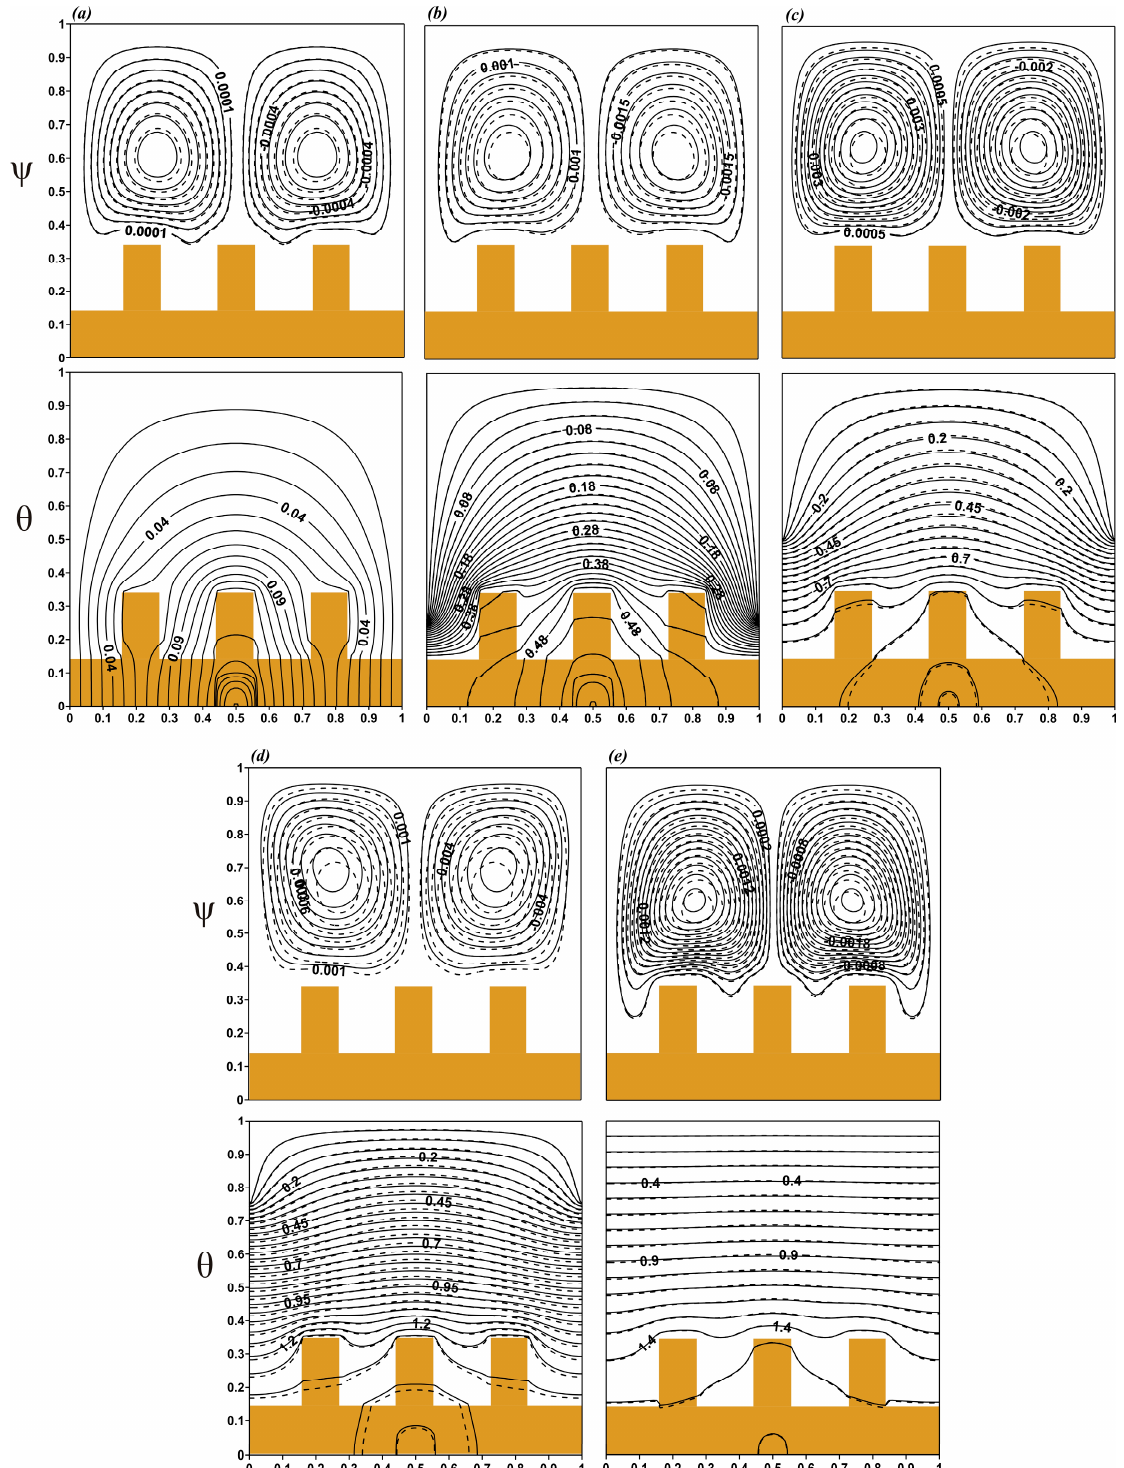
Figure 8. Isolines of ψ and θ for ζ = 0 (solid lines), ζ = 1 (dashed lines) and various values of h 1 : ( a ) h 1 = 0.0; ( b ) h 1 = 0.25; ( c ) h 1 = 0.5; ( d ) h 1 = 0.75; ( e ) h 1 = 1.0.